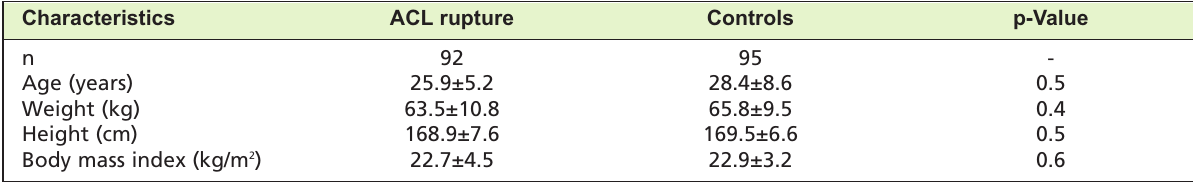
Baseline characteristics of ACL injury patients and healthy controls Table I: